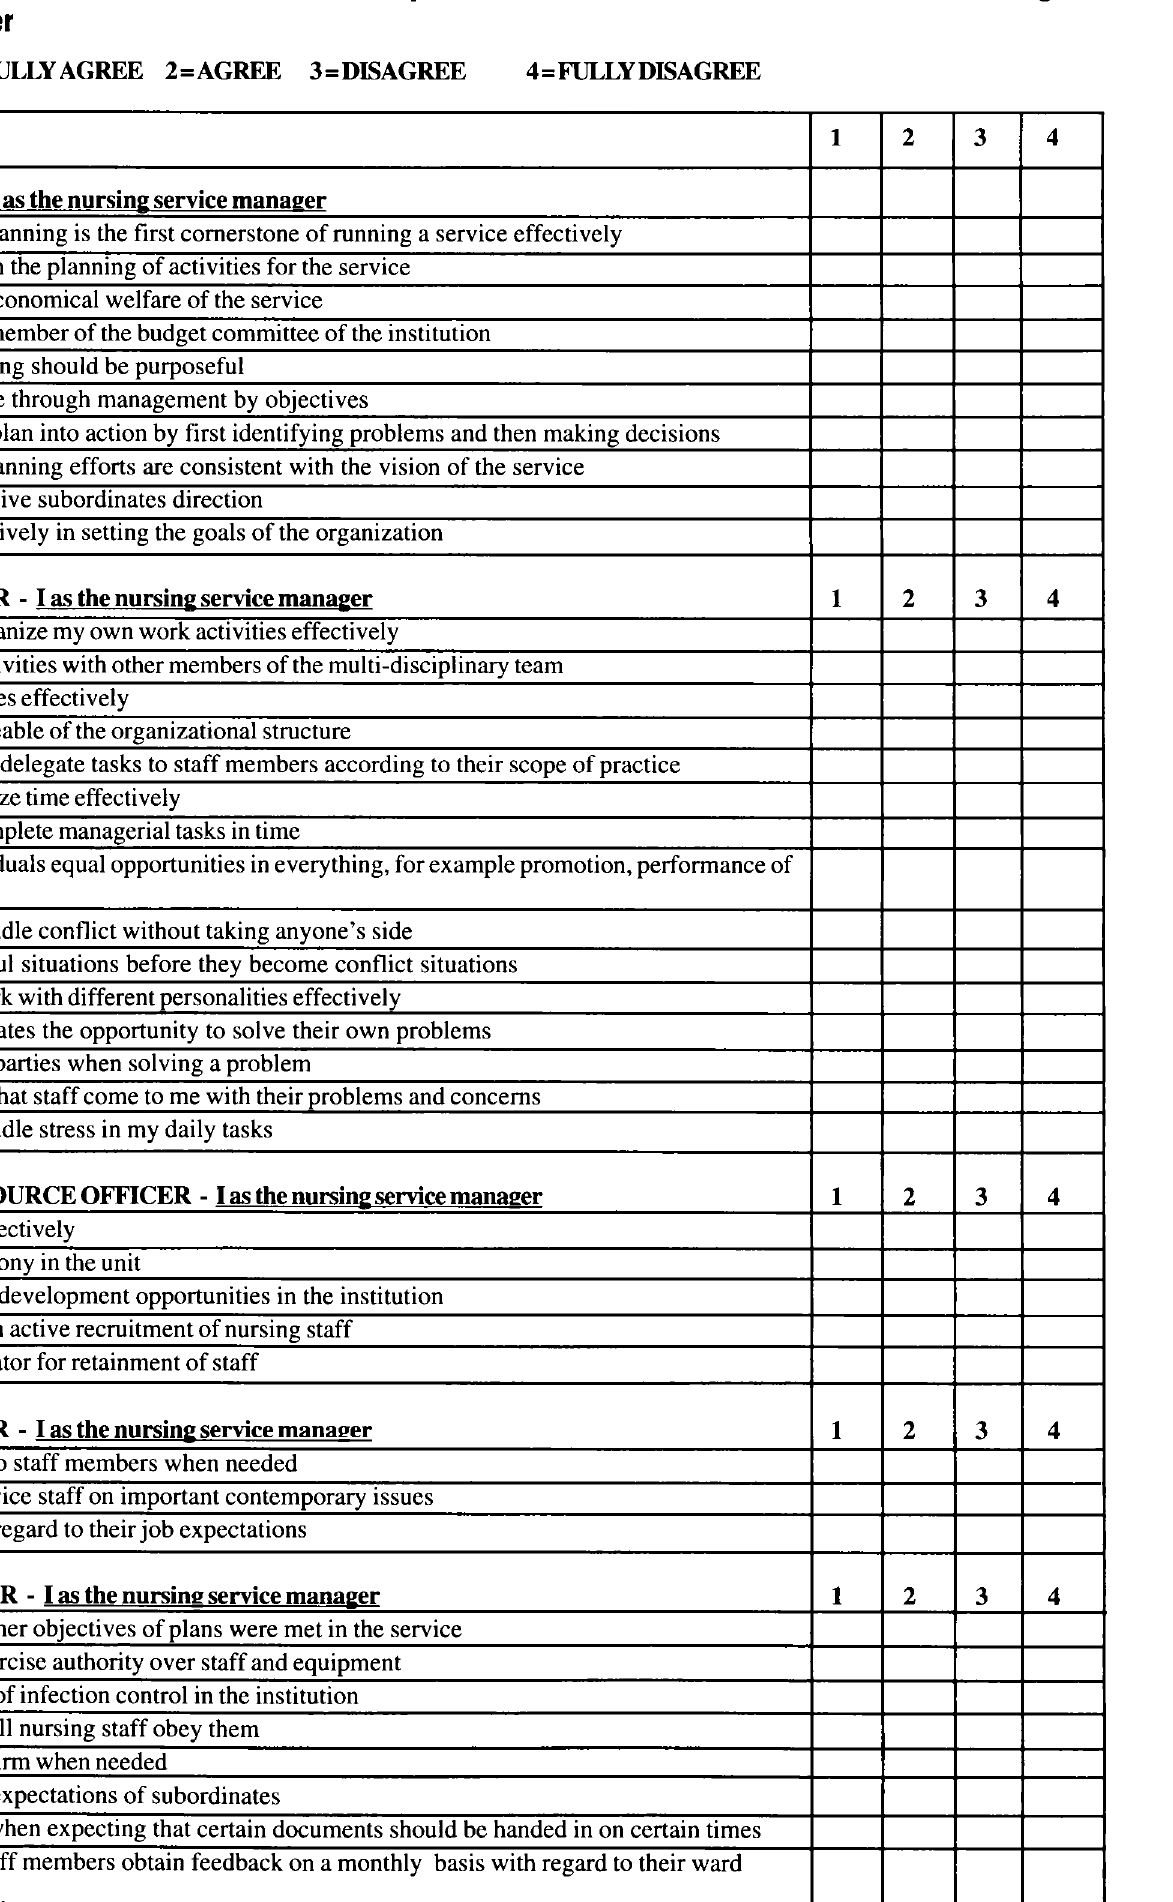
Table 1 : A self-evaluation instrument with examples of attributes needed to be an effective